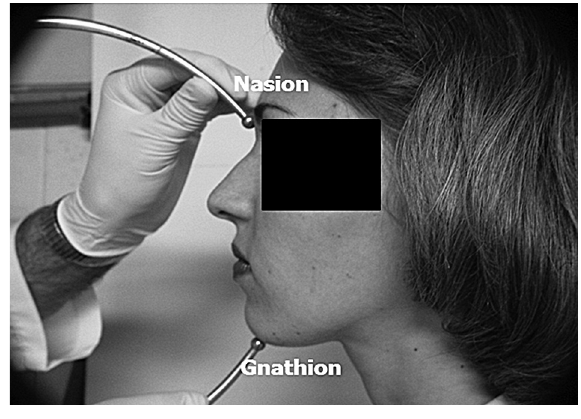
Figure 2. Total face height (nasion-gnathion: